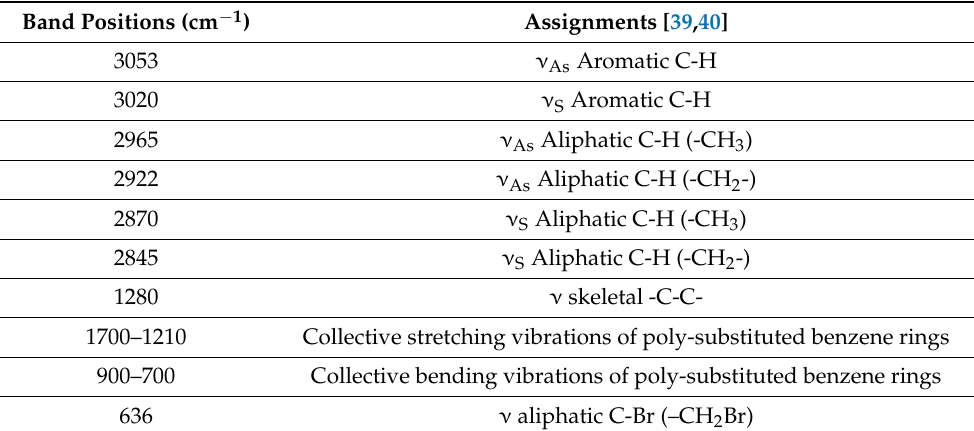
Table 2. Assignments of the main IR absorption bands of ABT